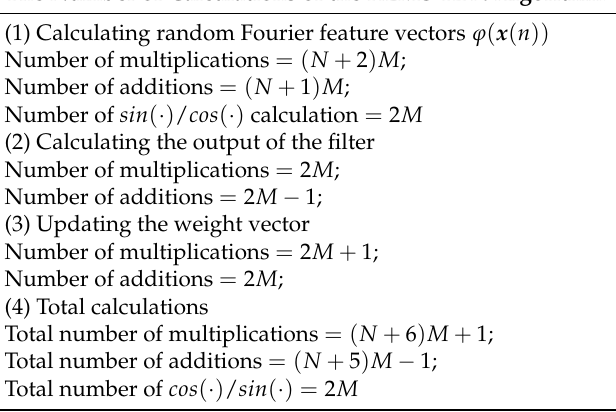
Table 1. The complexity of the KLMS-RFN